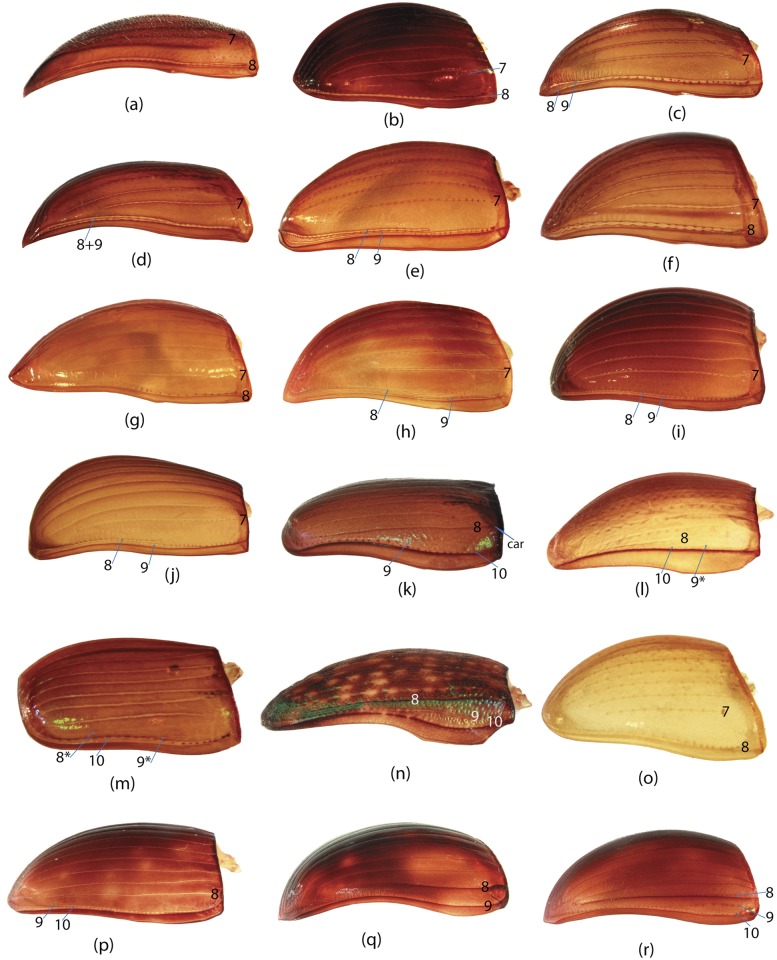
Elytra of Scarabaeinae.a, Aphengium cupreum; b, Ateuchus sp1.; c, Ateuchus sp2.; d, Scatimus strandi; e, Canthidium bokermanni; f, Uroxys epipleuralis; g, Uroxys pauliani; h, Homocopris torulosus; i, Ontherus appendiculatus; j, Uroxys latesulcatus; k, Canthon virens; l, Hansreia sp.; m, Anomiopus edmondsi; n, Megathoposoma candezei; o, Sinapisoma sp.; p, Copris sp.; q, Catharsius sp.; r, Metacatharsius sp.; a-r, right elytron, lateral view. Elytral striae are enumerated; indistinct striae or their traces are marked by *.